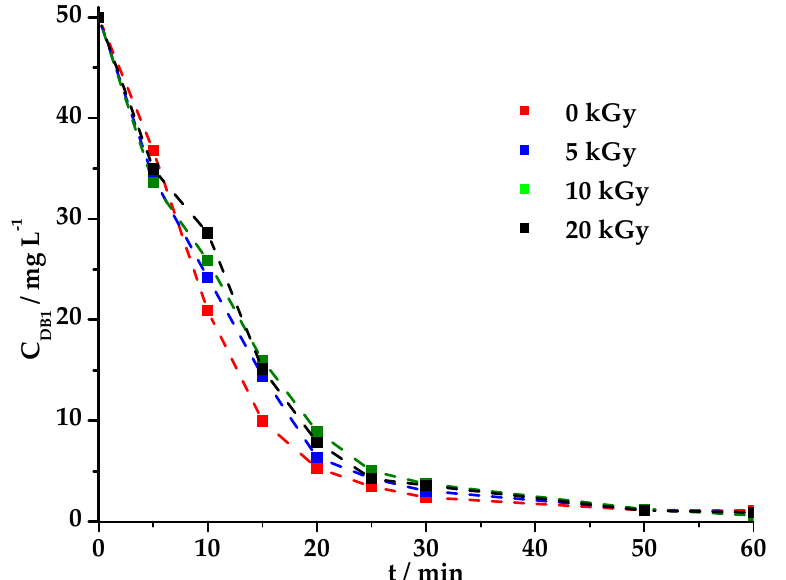
Figure 7. DB1 photodegradation on TiO 2 with and without e-beam treatment is displayed. Conditions: